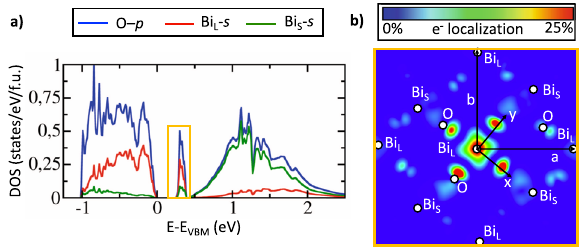
Fig. 3 Electronic properties of Sr 0.9375 K 0.0625 BiO 3 . a Projected density of states on O-p (in blue), Bi L -s (in red), and Bi S -s (green) states. The zero is set at the valence band maximum (VBM). The orange area indicates the intermediate states localized in the band gap. b Partial charge density maps associated with the intermediate states localized in the band gap corresponding to the orange area in panel a .